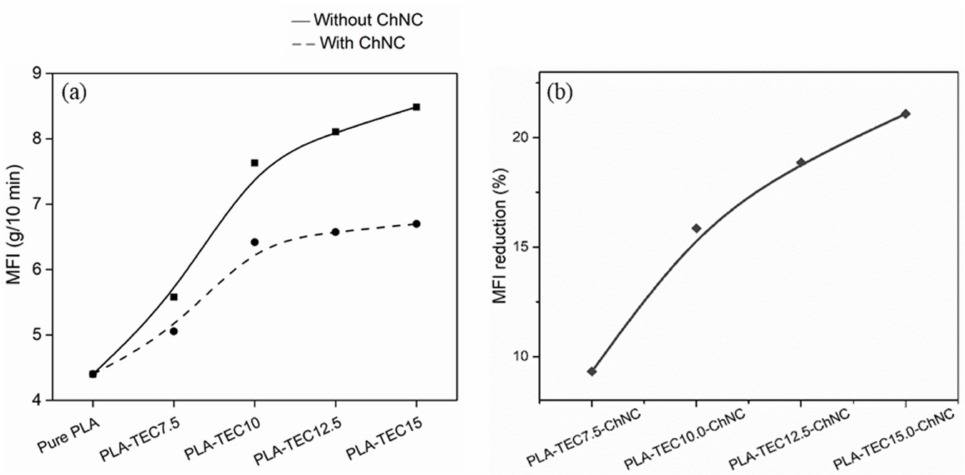
Figure 7. ( a ) Effect of ChNC on the melt flow index. ( b ) MFI reduction in nanocomposites in reference to their counterpart PLA-TEC.